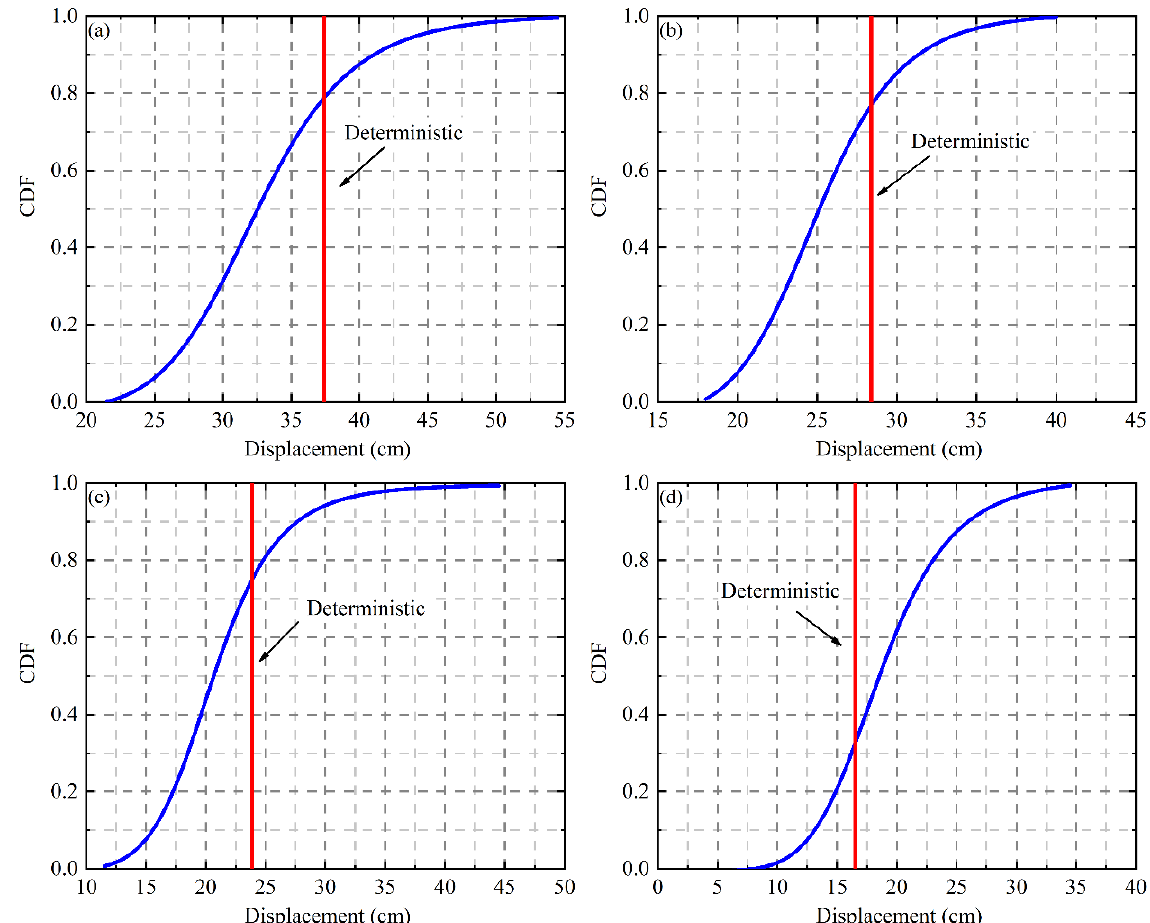
Figure 15. CDF of the peak value of tunnel uplift displacement at different embedment depths: ( a ) H = 6 m; ( b ) H = 8 m; ( c ) H = 10 m; ( d ) H = 12 m.